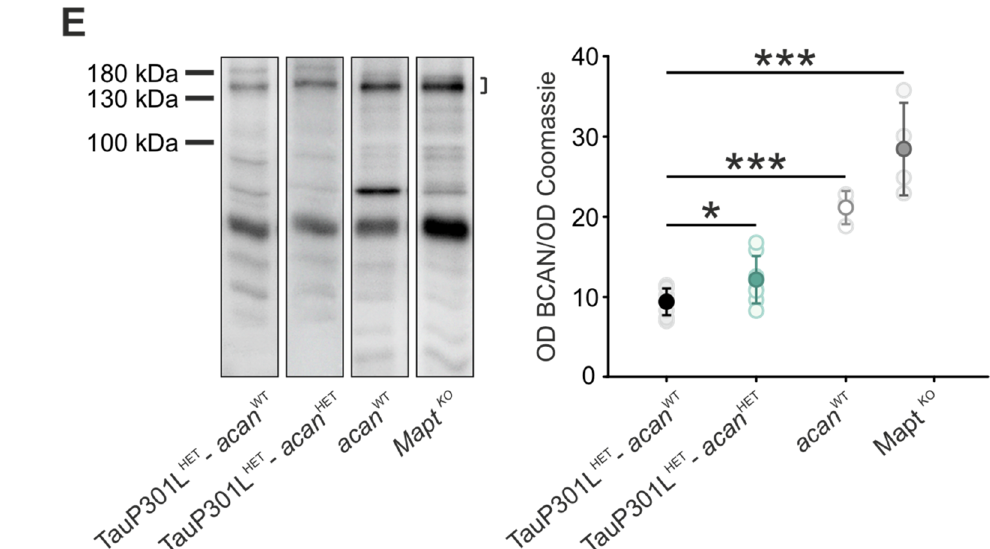
Figure 1. Characterization of brevican in the Mo5 of TauP301L- acan mice. ( A – D ) Immunohistochem- ical analysis of brevican (BCAN, clone 2 (BD Biosciences) in the motor trigeminal nucleus (Mo5) of 3 TauP301L HET - acan WT ( A , B ) and 3 TauP301L HET - acan HET mice ( C , D ). High magnification confocal images ( B , D ) of brevican immunoreaction visualize location and structure of the immunoreaction. Brevican was mostly localized extracellularly in TauP301L HET - acan HET ( C ) and TauP301L HET - acan WT mice ( A ). The structure of brevican immunoreaction did not yield any genotype-specific differences. However, an intracellularly clustered brevican immunoreactivity was detected in a few cells of TauP301L HET - acan WT mice ( B , arrows). ( E ) Western blot analysis of the amount of brevican full length protein (clone 2 (BD Biosciences), at ~145 kDa) in the brainstem with a significant increase in TauP301L HET - acan HET mice compared to TauP301L HET - acan WT mice ( p = 0.035, n = 8, t -test). Compari- son of brevican protein level in the control mice yielded striking differences. Brevican protein level was significantly reduced in TauP301L HET - acan WT mice compared to acan WT mice ( p < 0.001, TauP301L HET - acan WT n = 8, acan WT n = 3, t -test). The protein amount of brevican full length protein was significantly increased in Mapt KO mice compared to TauP301L HET - acan WT mice ( p < 0.001, Mapt KO n = 4, TauP301L HET - acan WT n = 8, t -test). For Western blot analysis protein extracts from homoge- nized brainstems of 8 TauP301L HET - acan WT , 8 TauP301L HET - acan HET , 3 acan WT and 4 Mapt KO mice were used. Optical density (OD) of the specific chemoluminescence signal was quantified in relation to Coomassie stained total protein bands. Quantified areas on the Western blot lanes were marked by a bracket. For illustration of exemplary blot lanes, brightness and contrast were adapted. Data are given as mean ± SD,* p < 0.05, *** p < 0.001. Scale bar in ( A , C ) 50 µ m, in ( A , D ) 10 µ